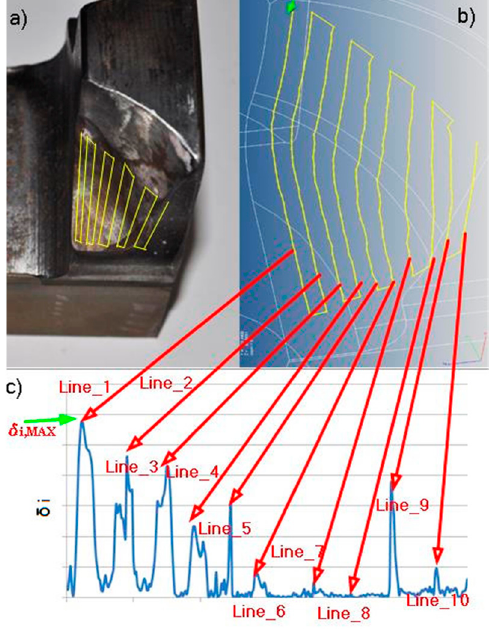
Figure 5. The concept of quantitative assessment of material: ( a ) the measurement site, ( b ) the measuring head route, ( c ) sample results Reproduced from [24], ScienceDirect: 2021.